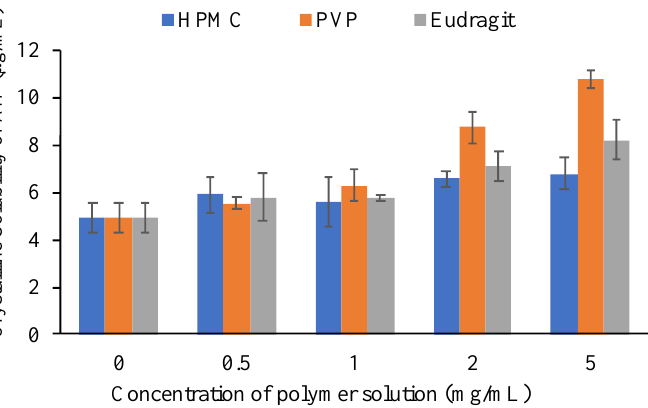
Figure 3. Crystalline solubility of AM at 25 ◦ C in the polymer solutions with various concentrations.